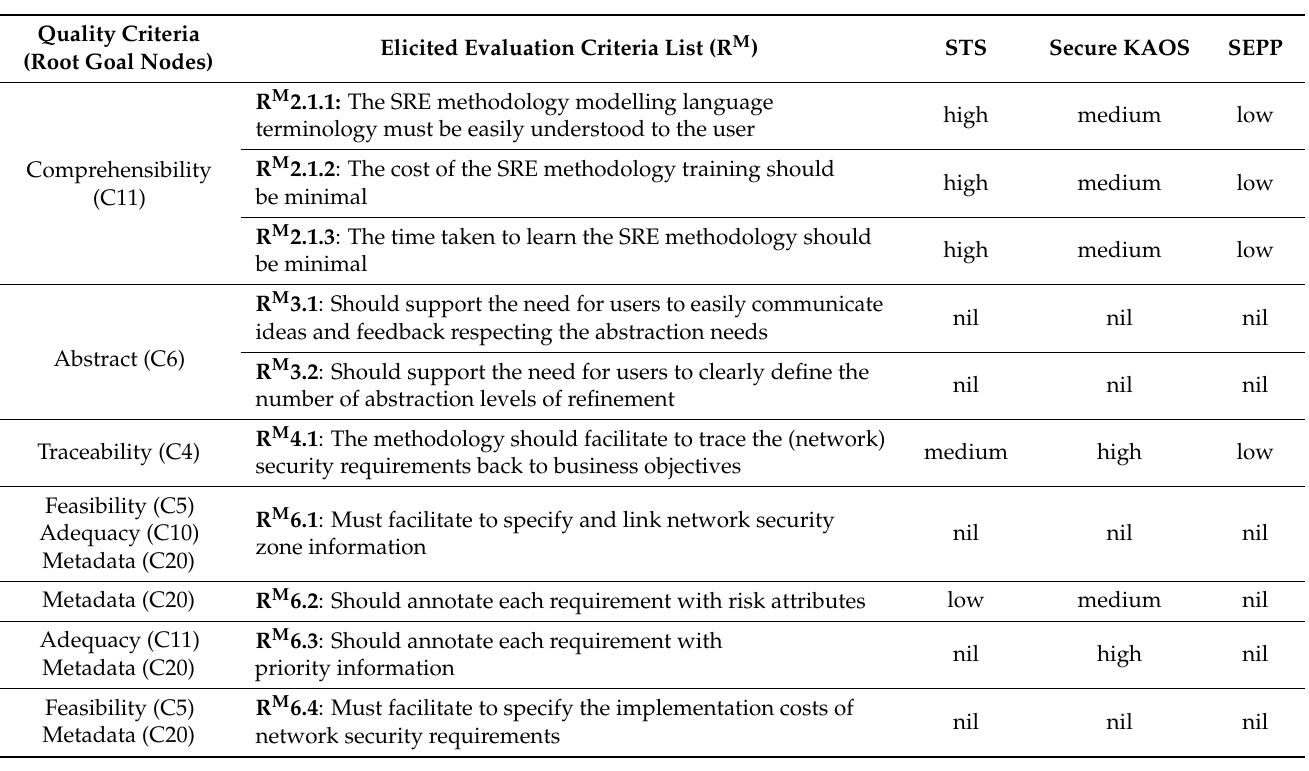
Table 6. Sample of the evaluation